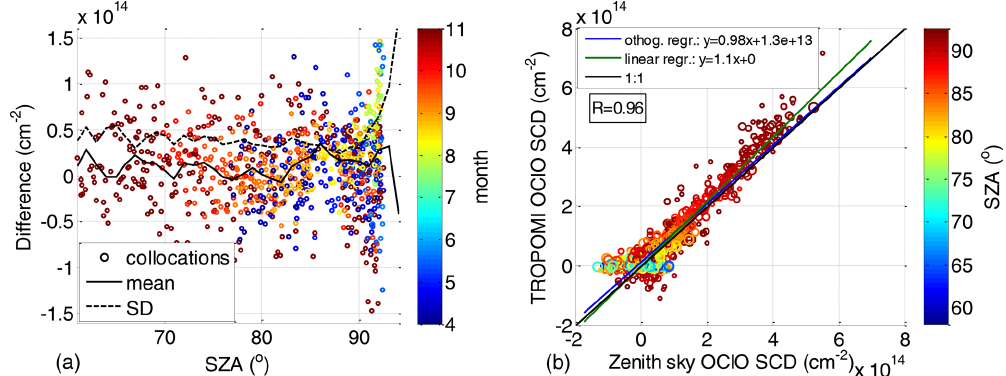
Figure 9. Same as Fig. 6 but with zenith sky OClO SCDs measured at Neumayer (70.64 ◦ S, 8.26 ◦